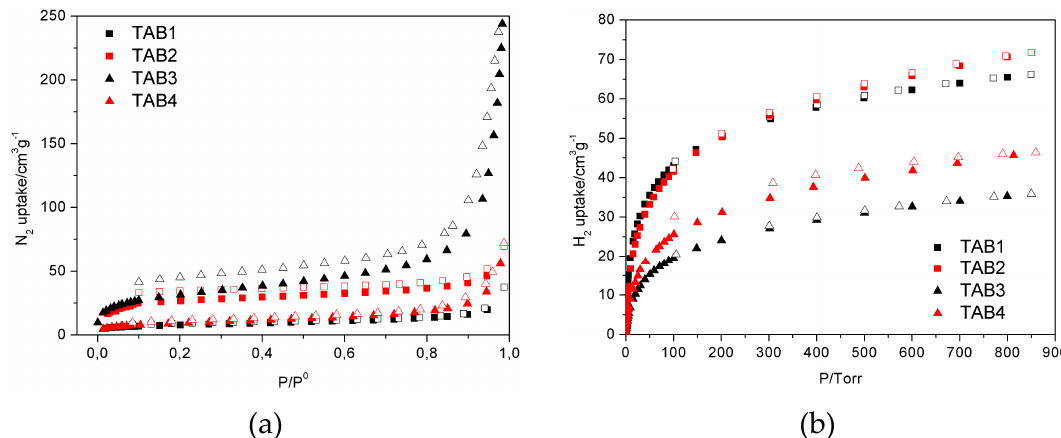
Figure 3. N 2 ( a ) and H 2 ( b ) sorption isotherms @77 K for materials TAB1–4.